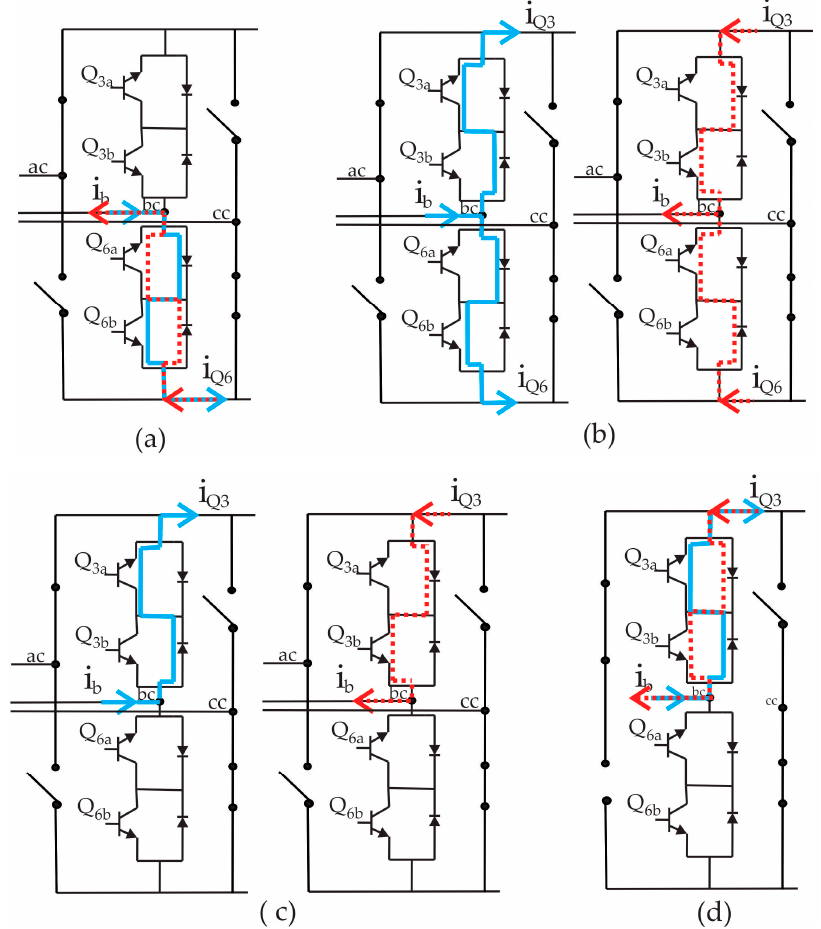
Figure 9. Switching sequence in the on-to-off transition from active-to-active switching state. ( a ) initial current flow; ( b ) overlap time; ( c ) current flow in the opposite direction; ( d ) bidirectional switch in on state.